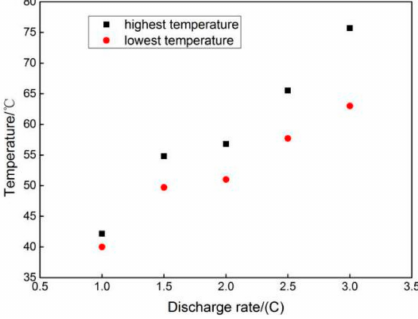
Figure 2. Battery surface temperature at di ff erent discharge